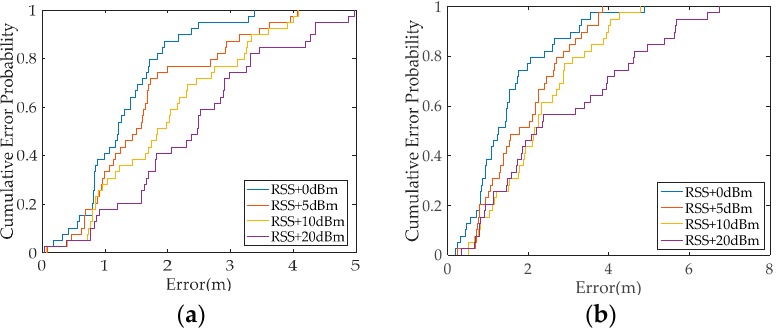
Figure 2. Positioning performance of conventional fingerprint methods when adding the test constant: ( a ) weighted K nearest neighbour (WKNN) algorithm and ( b ) Bayesian algorithm.